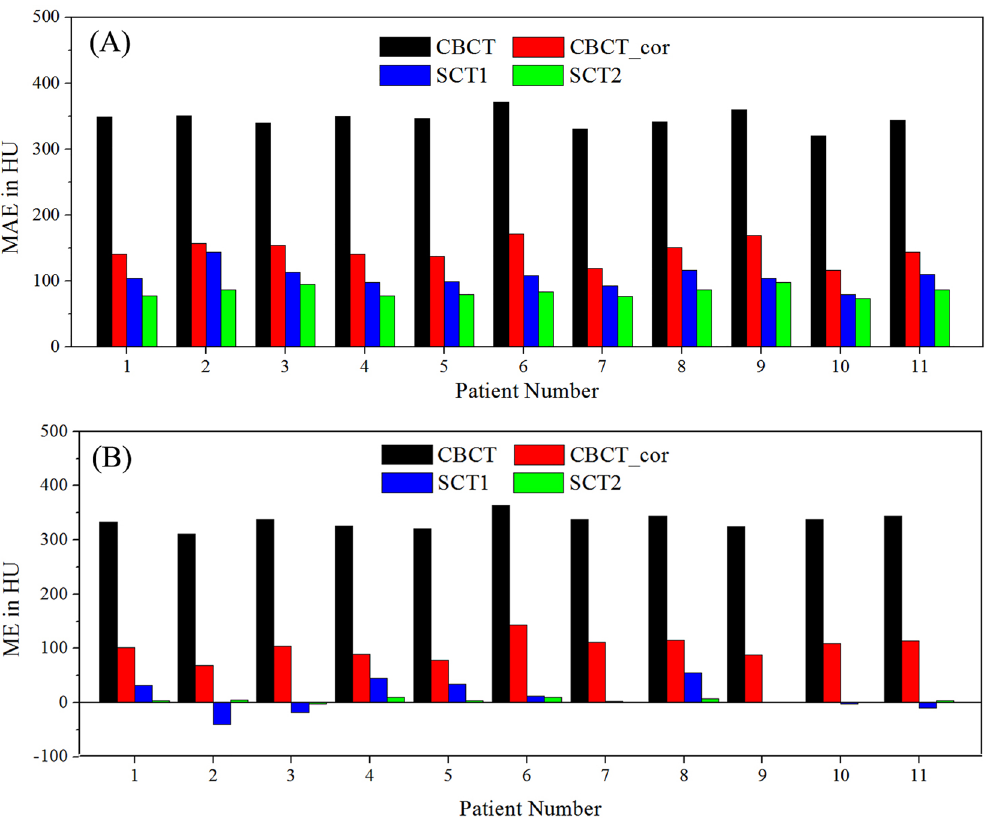
Figure 3. MAE and ME comparisons for each patient in validation cases. ( A ) MAE, ( B )